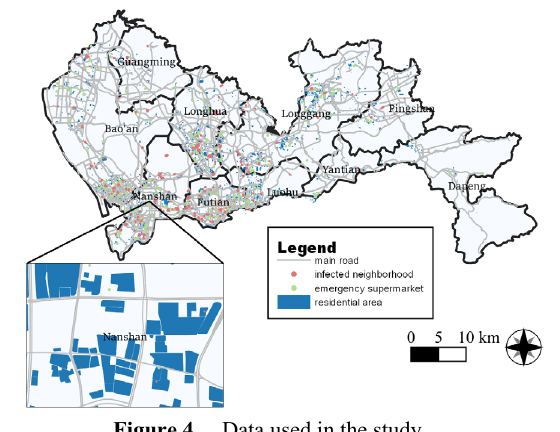
Figure 4. Data used in the